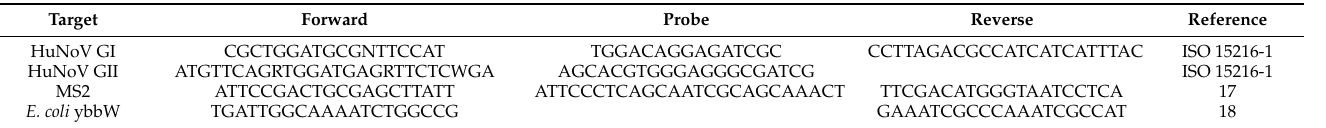
Table 1. Primers and probes sequences, and source for RTqPCR assays used in this study. Probes were labelled with 5 (cid:48) -carboxyfluorescein (FAM) and 3 (cid:48) -black hole quencher-1 (BHQ-1). Forward